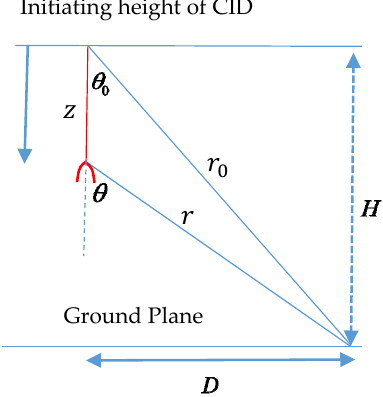
Figure 5. The geometry pertinent to the calculation of the radiation field generated during the initiation and branching of a streamer channel.